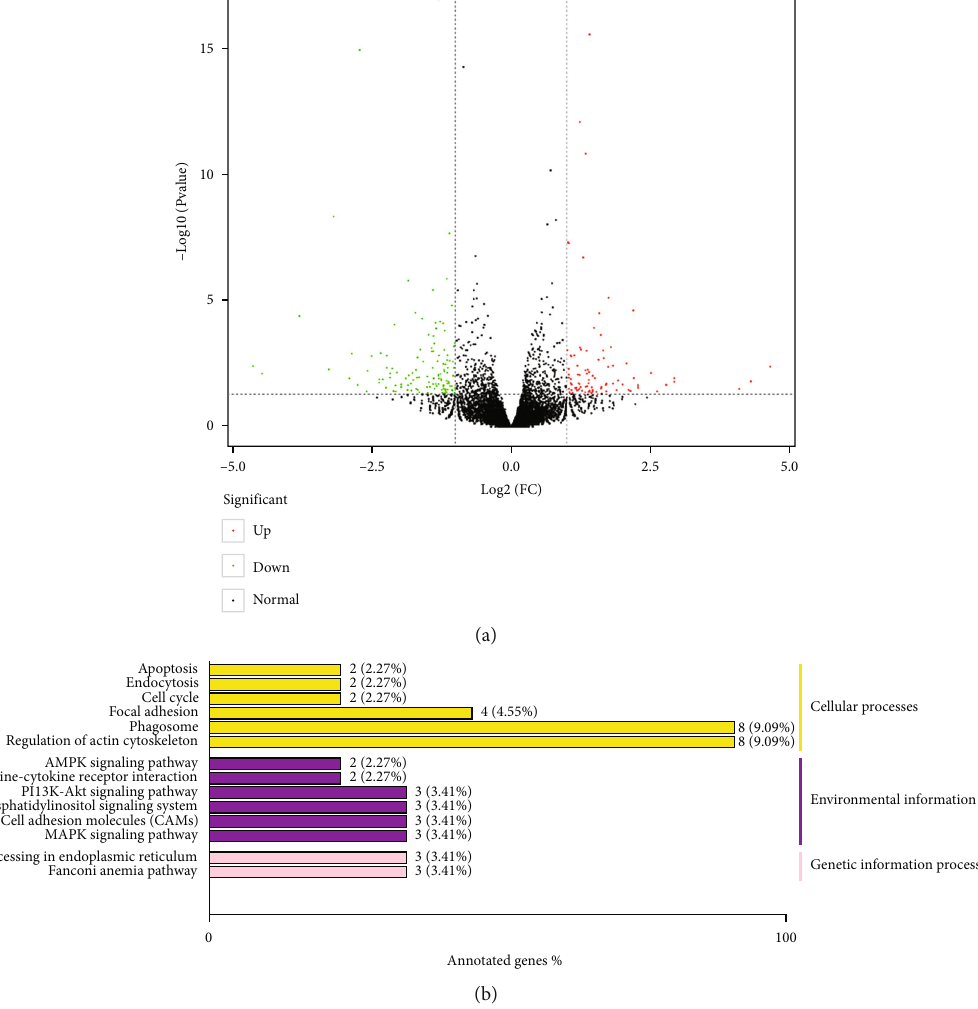
Figure 4: Transcriptome and pathway analysis of HUMSC-sEV treatment. (a) Volcano plot of DEGs between HUMSC-sEV-treated HCECs and HUMSC-sEV-untreated HCECs. Dots in green stand for downregulated DEGs, red dots mean upregulated DEGs, and black dots are nonsigni fi cant DEGs. (b) The KEGG annotation results of the DEGs were classi fi ed according to the pathway types in KEGG. DEG: di ff erentially expressed gene; KEGG: Kyoto Encyclopedia of Genes and